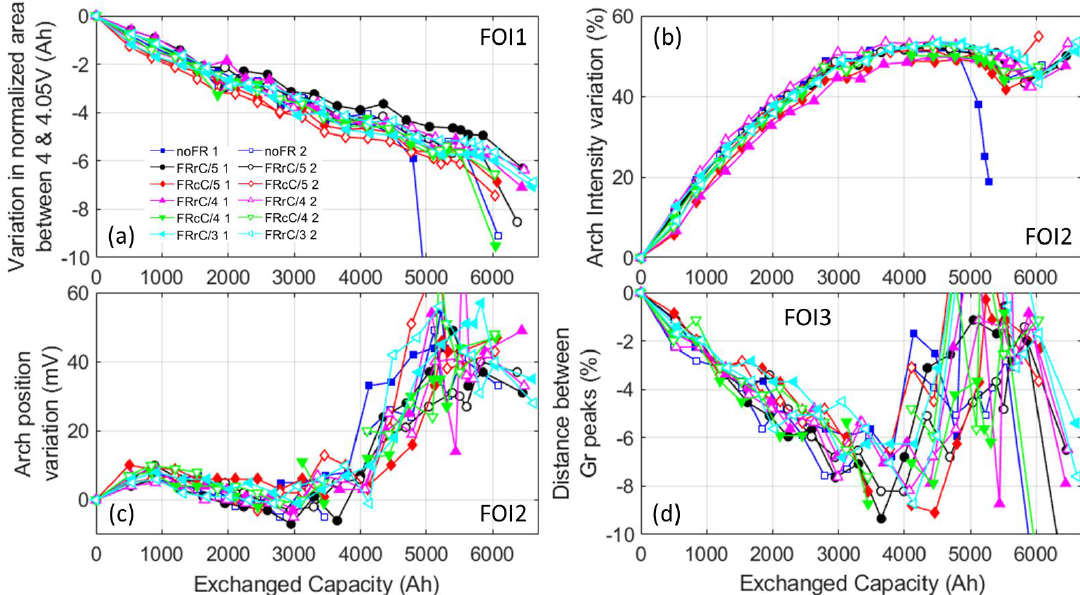
Figure 4. Evolution of ( a ) FOI1, the ( b ) intensity and ( c ) position of FOI2, and ( d ) FOI3.